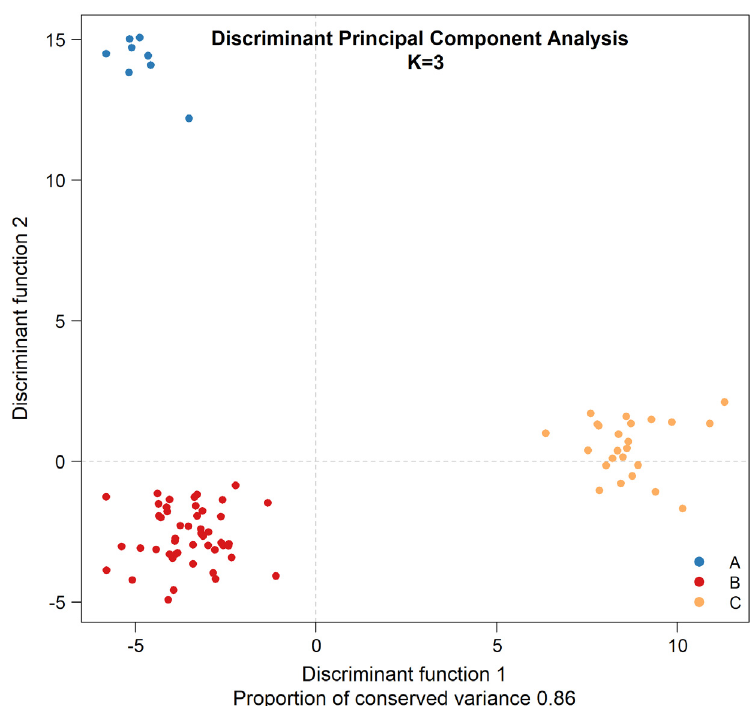
Fig. 3. Discriminant analysis of principal components of free-living Atlantic salmon genotypes. The first discriminant function distinguished between A and B from C clusters, whereas the second discriminant function distinguished A from B and C clusters. Individuals in cluster A correspond to admixed indi- viduals, while individuals in clusters B and C correspond to animals of pre- dominantly European